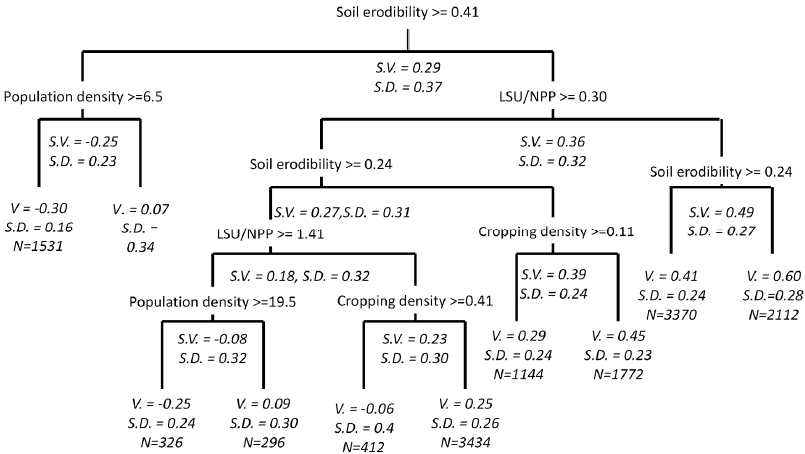
Figure 8. Pruned regression tree showing the hierarchical relations of RESTREND to land use, population, and soil erodibility. Regression tree r 2 = 0.6 and RMSE = 0.23; LSU/NPP (livestock unit density normalized by site net primary productivity); Cropping density (fraction land area used for crops); S.V. —node split value; S.D. —standard deviation of values at the node; V. —value at terminal node; N —number of observations at terminal node.